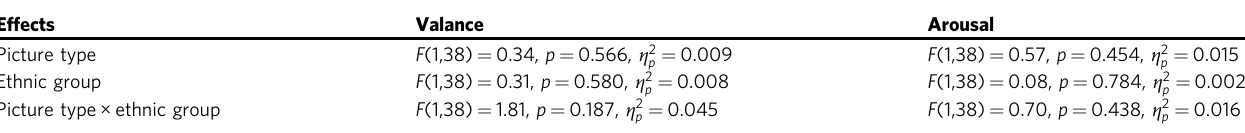
Table 3 Results of the ANOVAs for valance and arousal of experimental materials.